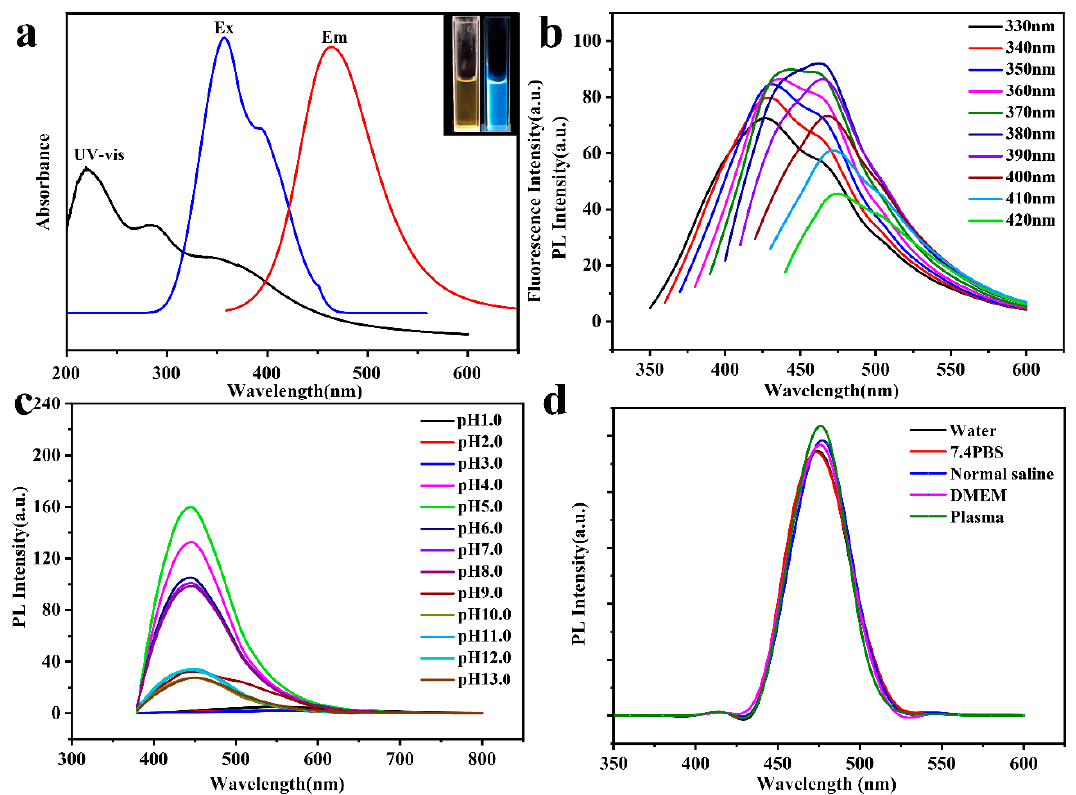
Figure 1. UV and photoluminescence spectra of CD C-H ( a ). The inset in Panel a: images obtained under daylight (left) and UV light illumination at 365 nm (right). The photoluminescent intensity emission spectra of CD C-H at different excitation wavelengths ( b ). The PL spectra of CD C-H at different pH ( c ) and different dissolution mediums ( d ).